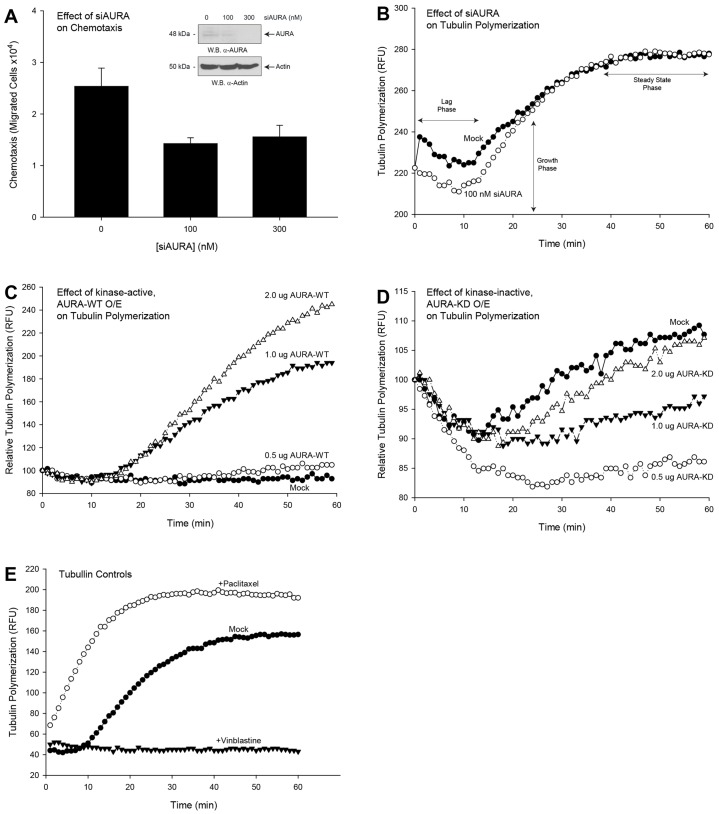
Silencing AURA reduced cell migration by modulating tubulin. Using COS-7 cell lysates that were silenced with up to 300 nM siRNA specific for AURA for 3 days, samples were prepared for SDS-PAGE and subsequent western blot analysis or for tubulin polymerization assays. (A inset) Western blot analyses of COS-7 cell lysates that were transfected with increasing siRNA specific for AURA (siAURA). (A) Enhanced cell migration is decreased in cells treated with increasing amounts siAURA. Experiments were performed in triplicate and are expressed as the mean±s.e.m. number of cells that migrated (percentage of control) *P<0.05 increases and #P<0.05 decreases between samples and controls. (B–D) Tubulin polymerization of cells that were either silenced for AURA (siAURA) or that overexpressed (O/E) AURA. (B) Tubulin polymerization was reduced early in the polymerization reaction and not at later times as a result of silencing AURA as compared to non-silenced samples. (C) Overexpressed wild-type AURA (AURA-WT) had a positive effect on tubulin polymerization compared to mock cells. (D) The positive effect on tubulin polymerization was reversed when the kinase-inactive mutant AURA-D274A (AURA-KD) was overexpressed. (E) Tubulin polymerization positive (taxol) and negative (BSA) controls. Experiments were performed in triplicate and are expressed as the mean relative number of fluorescence units (RFU).